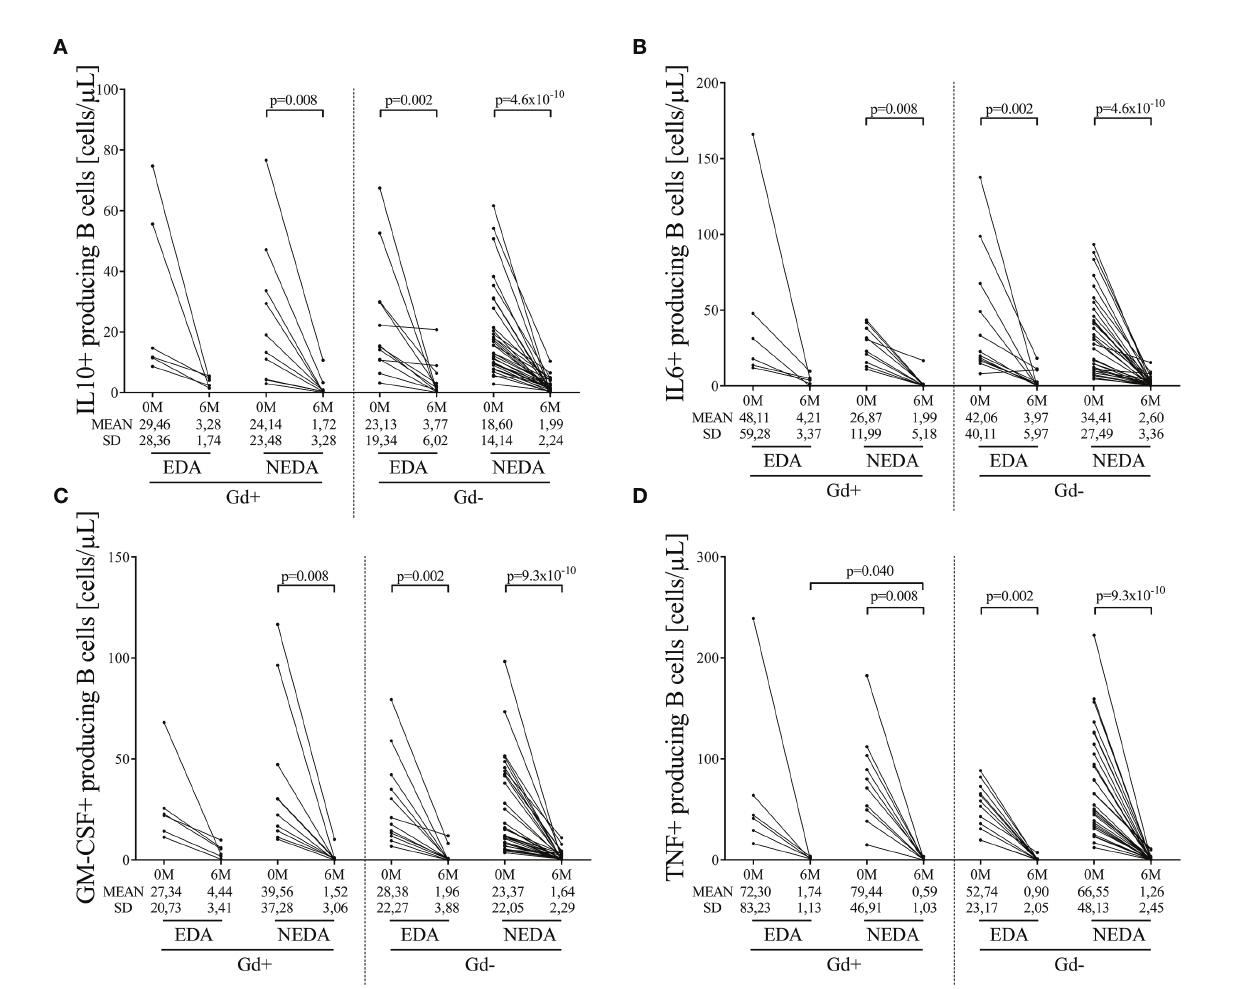
FIGURE 2 | Changes in blood cytokine-producing B cells on ocrelizumab treatment. Cytokine-producing B cells were obtained before (0M) and at 6 months (6M) of ocrelizumab treatment and classi fi ed based on their in fl ammatory status (presence [Gd+] or absence [Gd-] of gadolinium enhancing lesions at baseline) and response (NEDA or EDA) to treatment at one year of follow-up. N was 6, 10, 12 and 41 in Gd+ EDA, Gd+ NEDA, Gd- EDA and Gd- NEDA, respectively. Graphs showing changes in absolute numbers (cells/ m L) of IL-10 (A) , IL-6 (B) , GM-CSF (C) , and TNF a (D)- producing B cells. IL, interleukin; GM-CSF, granulocyte-macrophage colony-stimulating factor; TNF, tumor necrosis factor alpha; SD, Standard deviation. Bonferroni-corrected p-values are